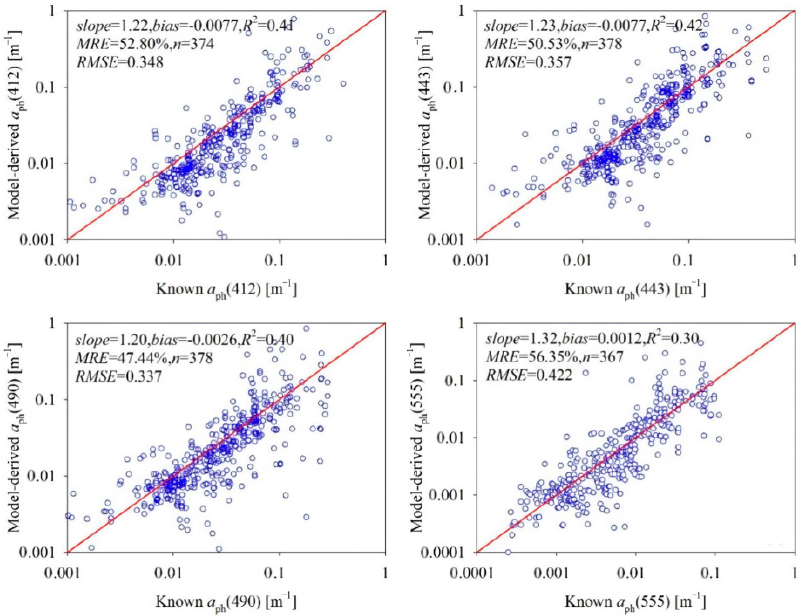
Figure 11. Precision of the remote-sensed coefficient of absorption of phytoplankton utilizing the GIOP model.